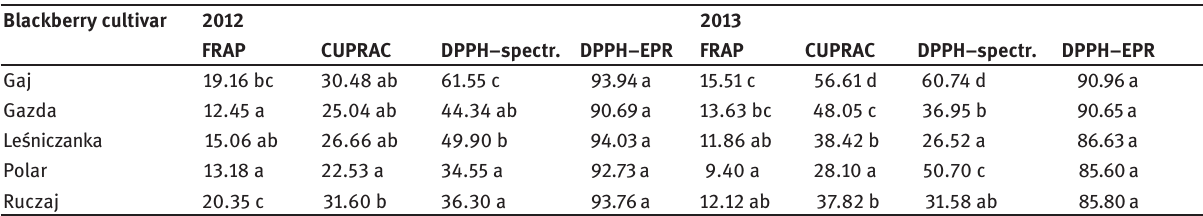
Table 6: Antioxidant activity of the tested blackberry fruits. Blackberry cultivar